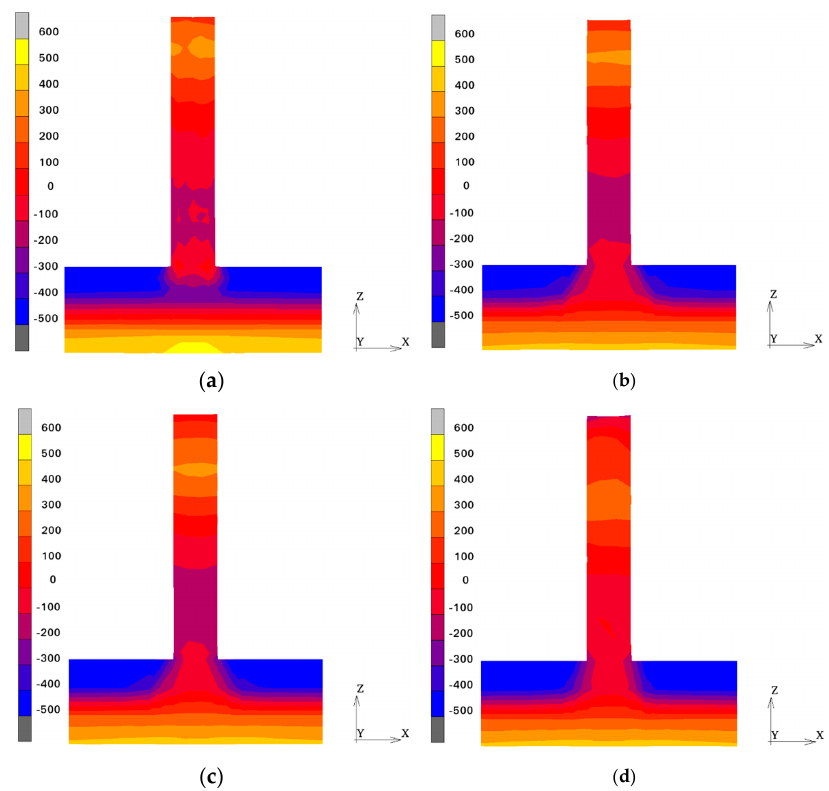
Figure 13. Residual stress in the welding direction (MPa) in the mid cross section of the case with no dwell time between layers for the model with fine mesh ( a ), and the models with lumping of three passes ( b ), six passes ( c ), and 14 passes ( d ). Table 7. Residual stress in the welding direction at the bottom center of the substrate in the case with no dwell time between layers.